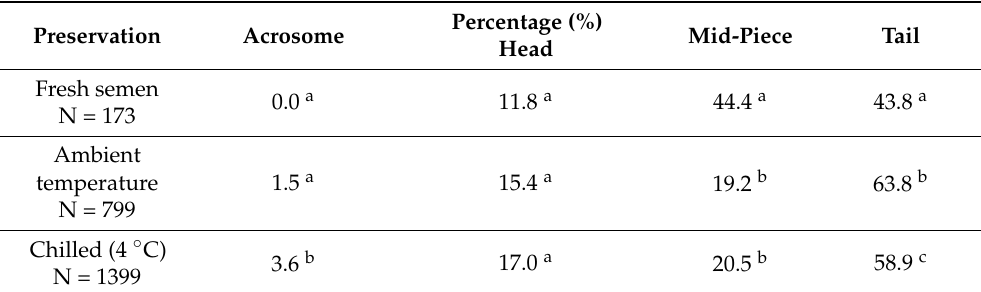
Table 7. Proportions of different sperm morphological defects in different preservation conditions applied to turkey